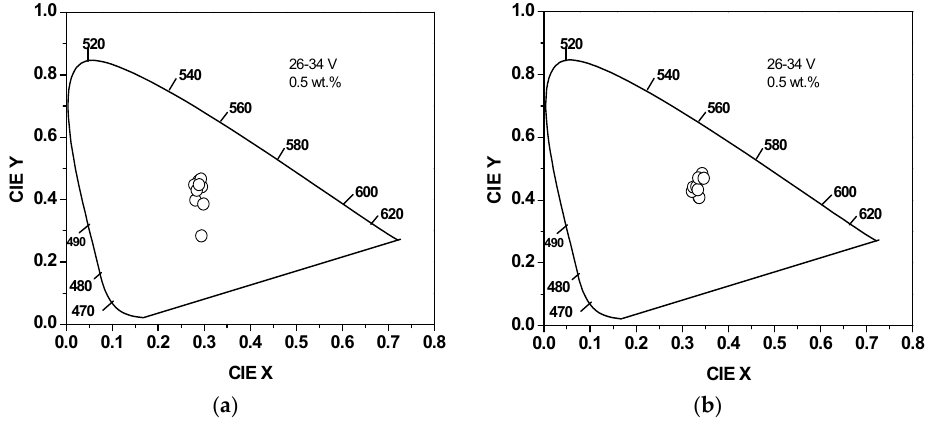
Figure 3. CIE coordinates of the OLEDs based on PFO/MEH-PPV hybrids when the applied voltage was increased from 26–34 V. ( a ) In the absence of SiO 2 /TiO 2 nanocomposites, ( b ) in the presence of SiO 2 /TiO 2 nanocomposites. Table 1 summarizes the CIE chromaticity coordinates of the OLEDs based on PFO/MEH-PPV hybrids, with and without SiO 2 /TiO 2 nanocomposites, at the applied voltage that caused the highest luminance. The slight shift in CIE coordinate values upon the increment of the MEH-PPV content confirmed that the produced color was stable and consistent with the EL spectra. Table 1 . The CIE chromaticity coordinates delivered by the OLEDs at the applied voltage, which caused highest luminance. Acceptor Content in the Blend (wt.